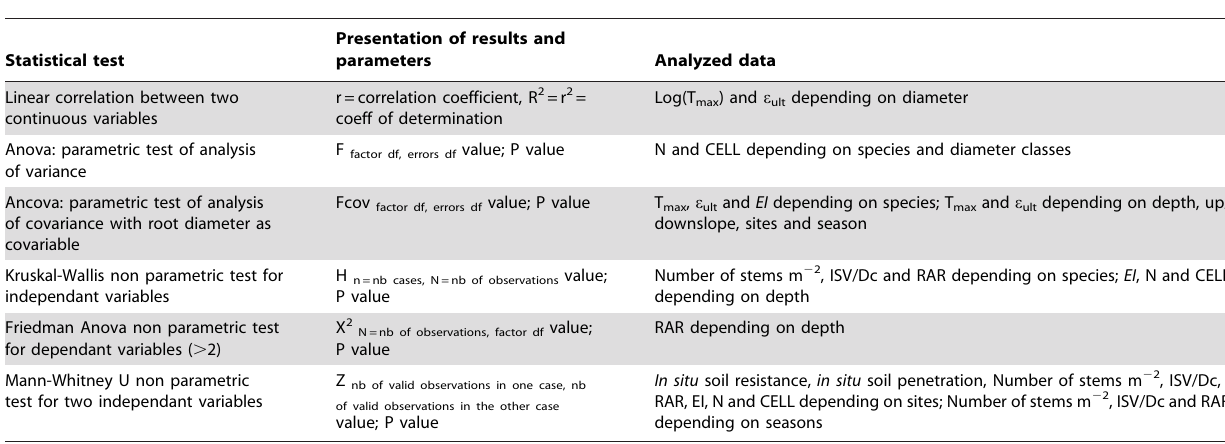
Table 4. Different statistical tests were used depending on the variables